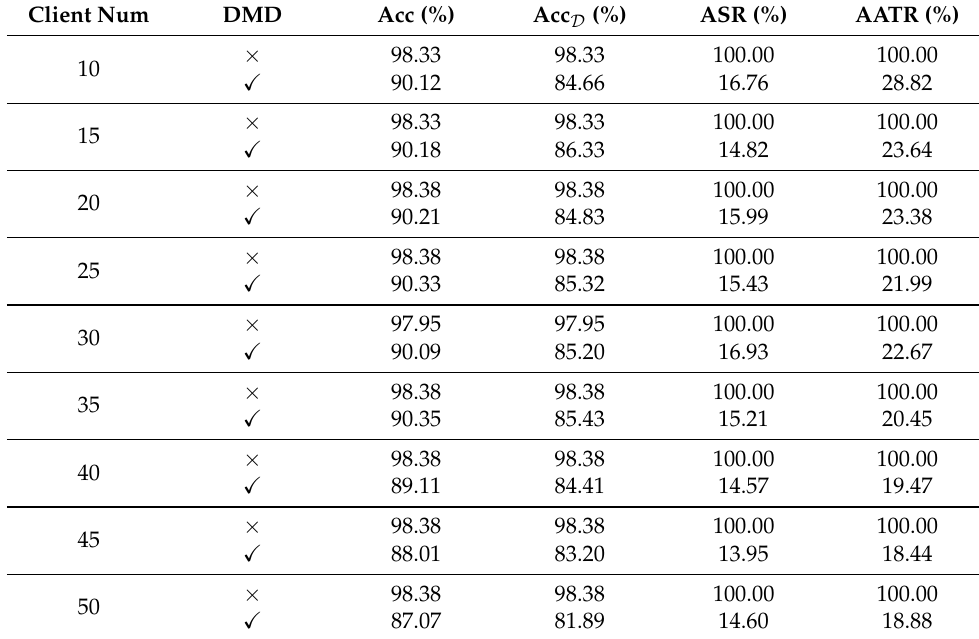
Table 1. Results of FL with/without DMD under different settings for MNIST.